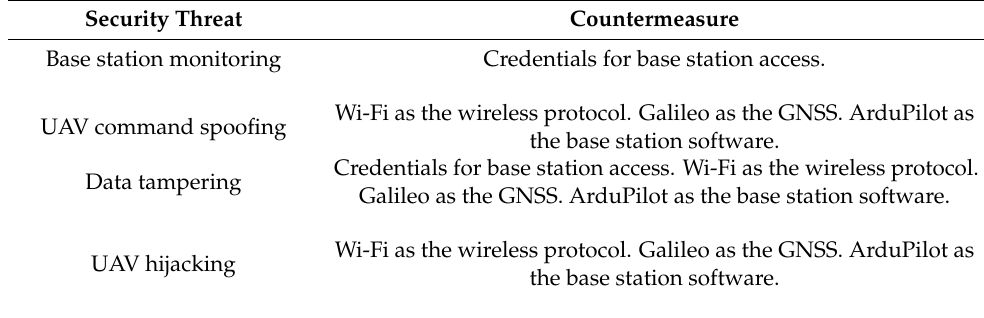
Table 3. Security threats and their countermeasures.